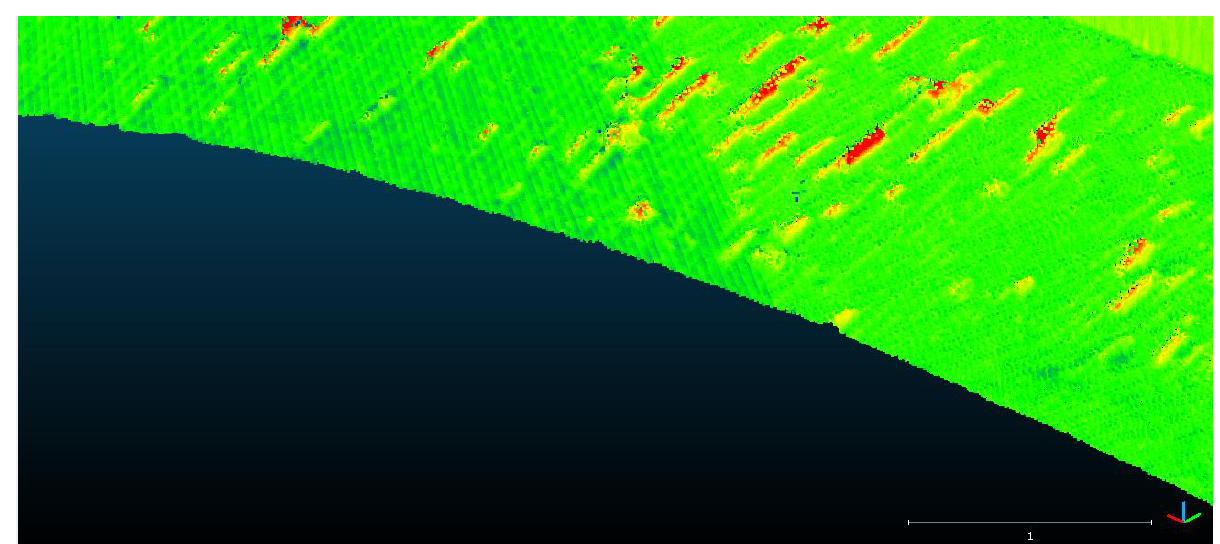
Figure 6 - Surface comparison through Cloud Compare